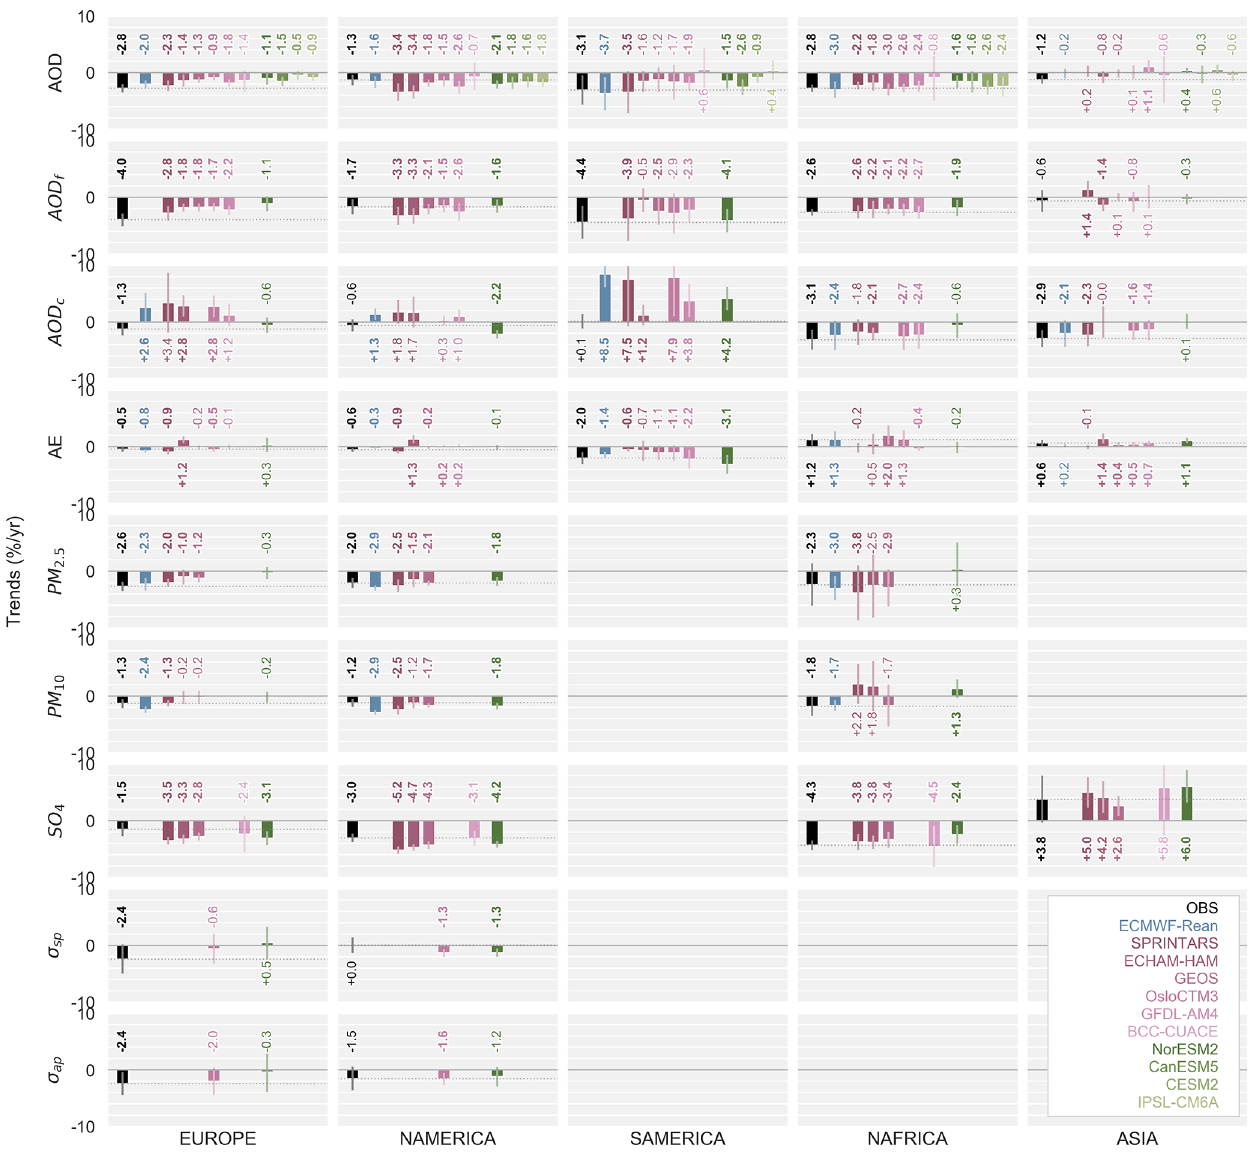
Figure 6. Regional trends in the aerosol properties computed with observations and models co-located in space and time with the obser- vations. The error bars correspond to the uncertainty in the trend as calculated using both the uncertainty in the Theil–Sen slope and the residuals. The bold font indicates that the trends are significant at a confidence level of 95% ( p value < 0.05).